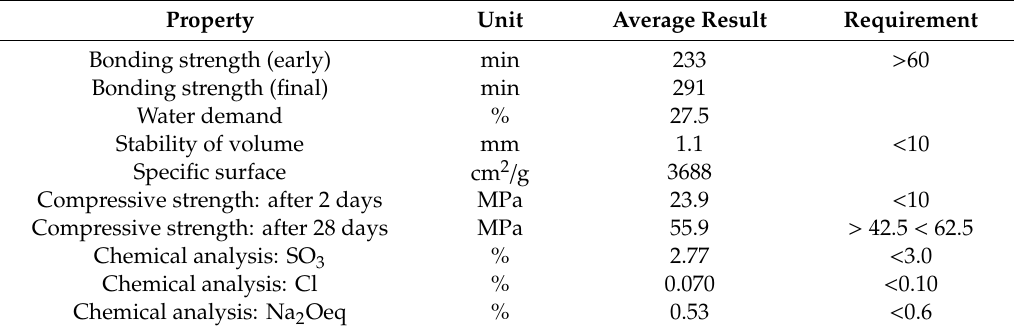
Table 2. Physical and chemical parameters of cement CEM I 42,5N–SR 3 /